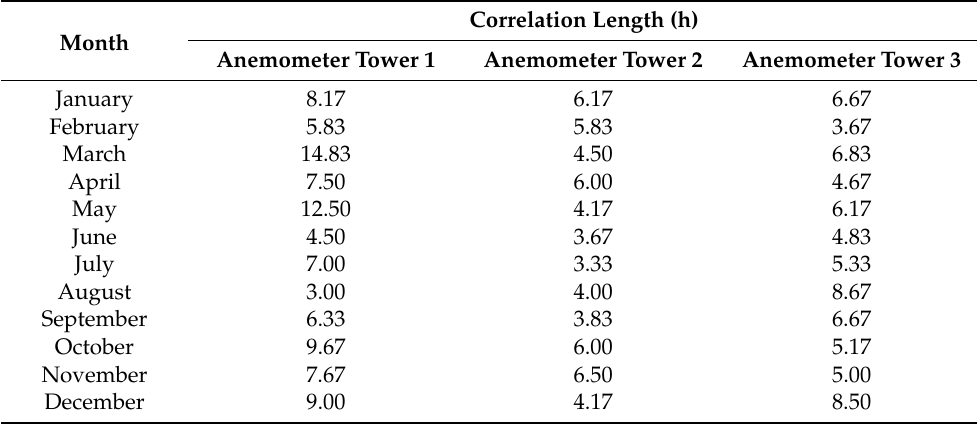
Table 2. Correlation length of wind speed series when MIC equals